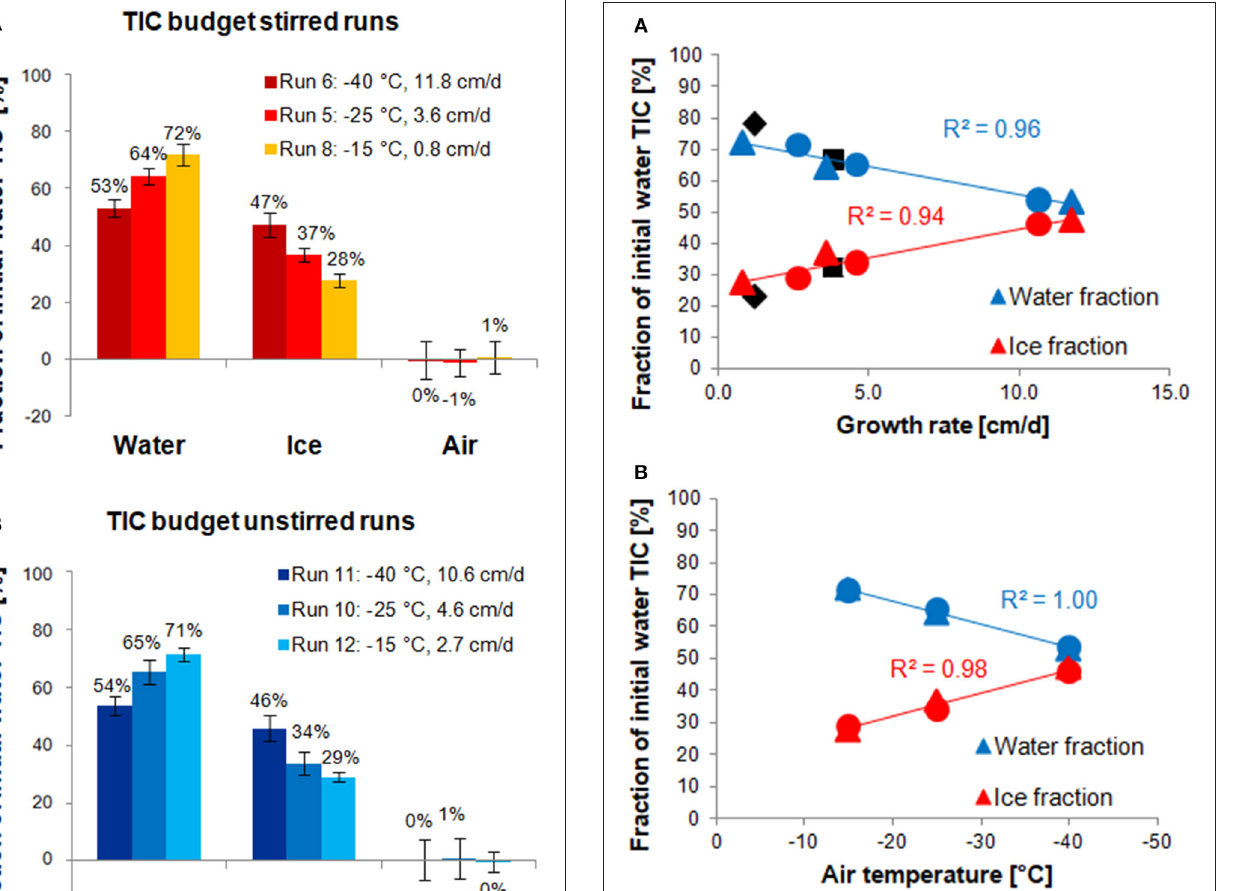
Frontiers in Earth Science |